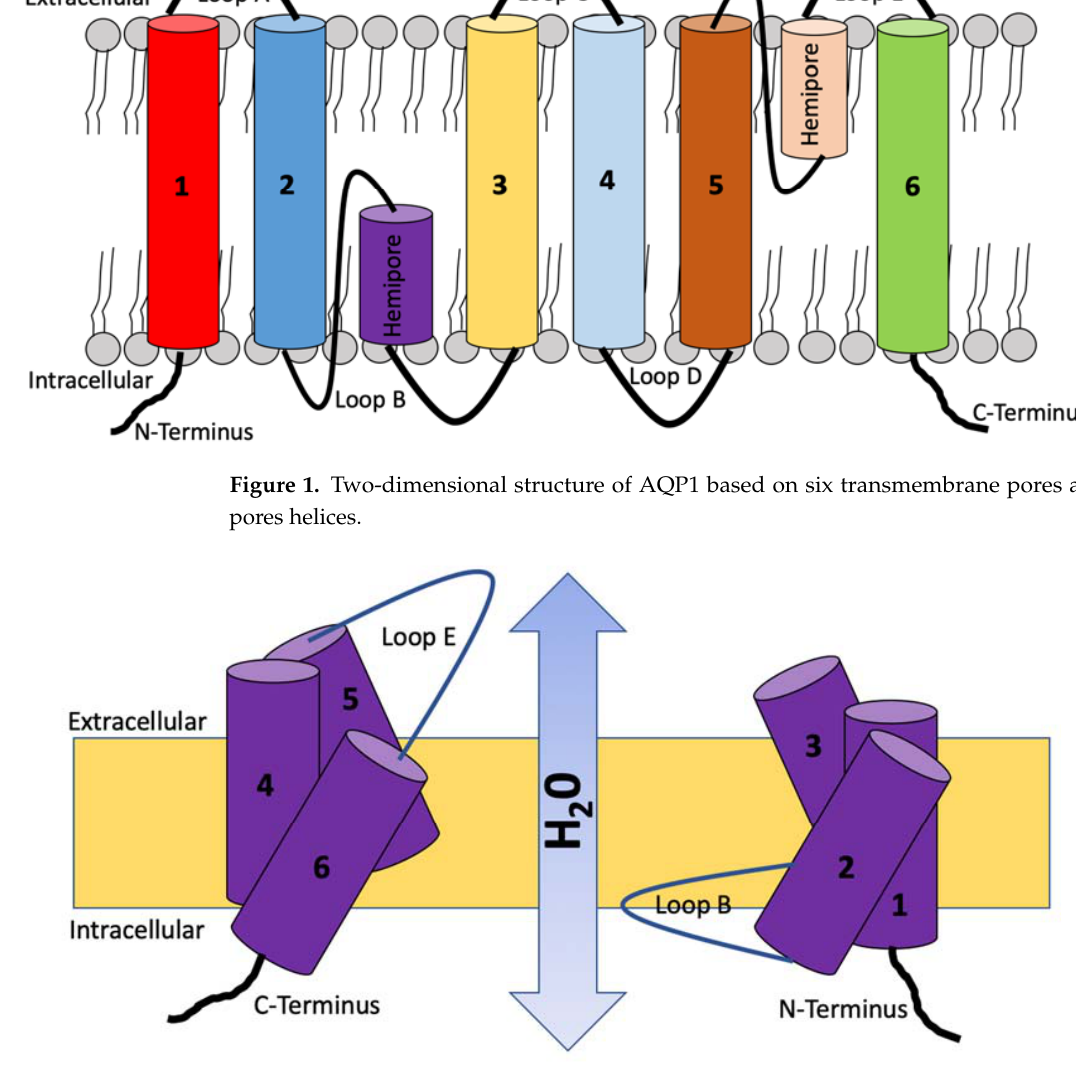
Figure 2. Two-dimensional structure of AQP1 showing the water passage across the pore.